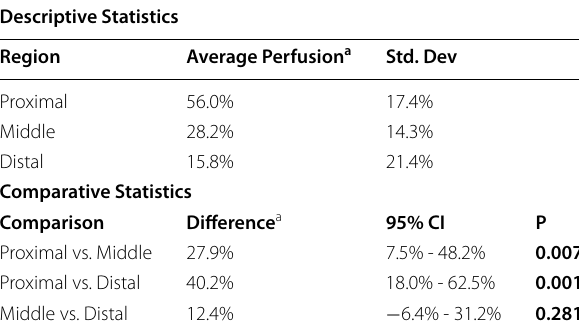
Table 1 Descriptive and Comparative Statistics for Regional ACL